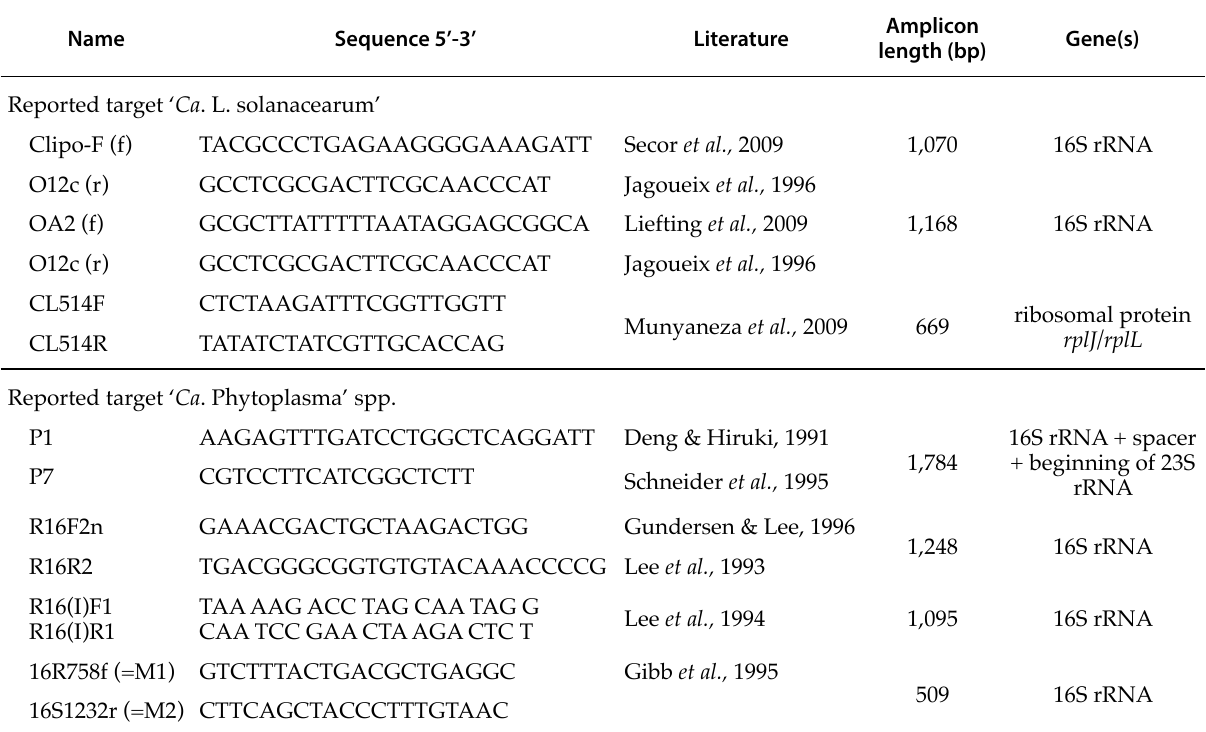
Table 1. The table describes the PCR systems used to detect ‘ Ca . L. solanacearum’ presence in carrot DNAs using primer pairs specific for its 16S rRNA (Clipo-F /O12c and OA2/O12c) and ribosomal protein rplJ/rplL (CL514F/CL514R). To detect ‘ Ca . Phytoplasma’ spp. The phytoplasma universal (P1/P7, R16F2n/R16R2 and M1/M2) and group 16SrI- specific primers (R16(I)F1/R16(I)R1) were employed.